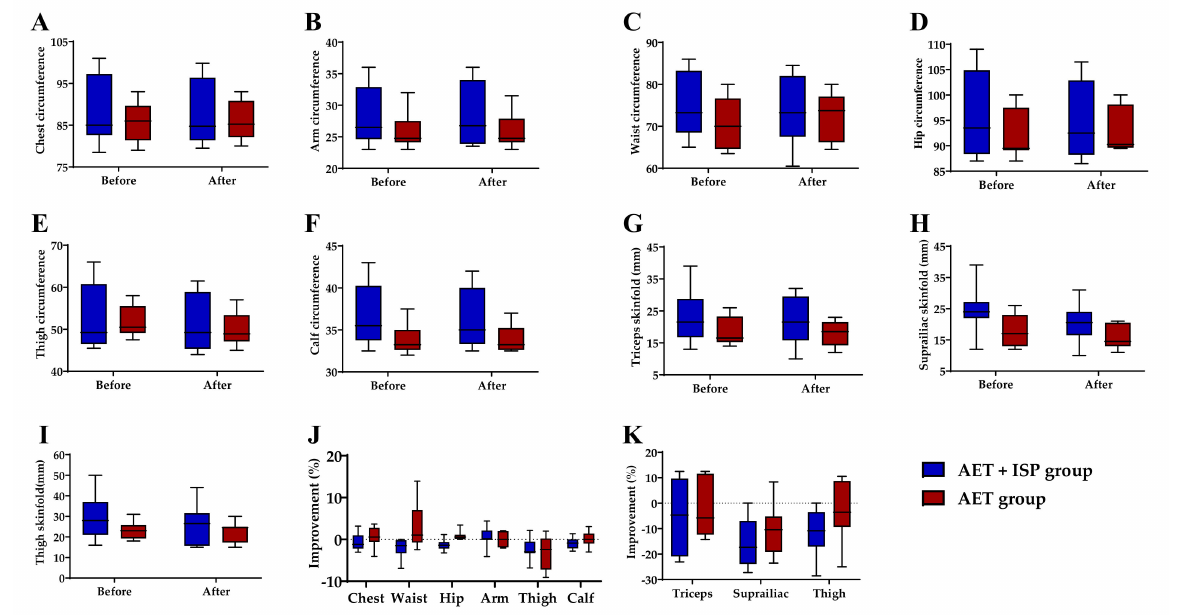
Figure 2. Changes in various body sites, as indicated, for the AET and AET + ISP groups before and after 8 weeks of intervention: ( A – F ) circumference changes (cm); ( G – I ) thickness of skinfold changes (mm); ( J ) improvements in the circumference (%); ( K ) improvements in the thickness of skinfold (%). The improvement in anthropometric characteristics means the reductions in value for circumference and thickness of